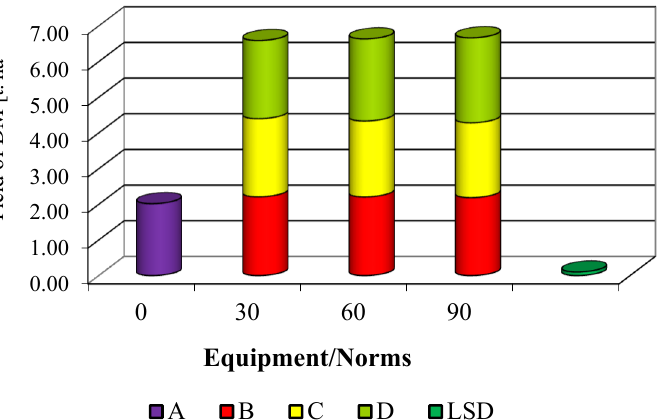
Figure 3. The influence of tillage equipment’s and reseeding norms of T. repens on the yield of ADM (Mean of pasture rotations). Tillage treatments: A—control object (without overseeding), B—underseeding after heavy tine harrow, C—underseeding after disc harrow, D—underseeding after the rotary